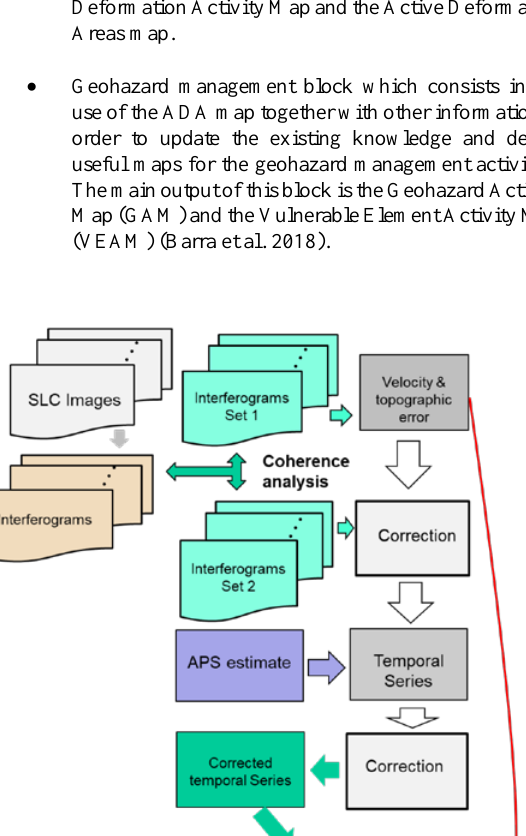
Figure 5: (a) Amplitude image of a GBSAR acquisition (VV pol) in radar coordinates, (b) photo of the main area of the landslide.